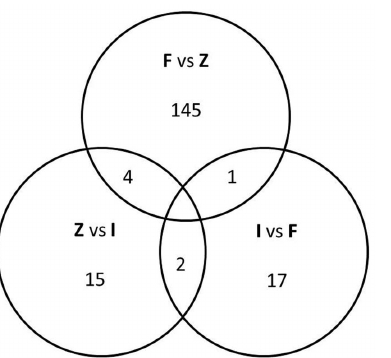
Table 4; ARHGEF10, PHPT1, MGC31963, LAF4 and B3GNT